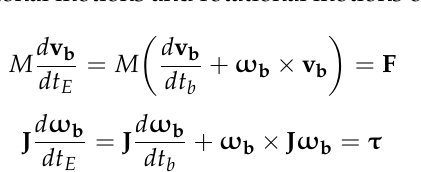
Figure 3. Head part schematic drawing of the proposed system.